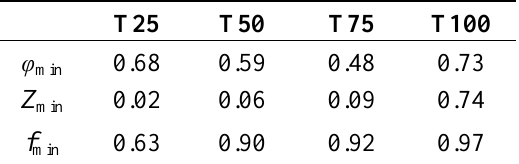
Table 5. Statistical analysis of φ coefficient for each of φ